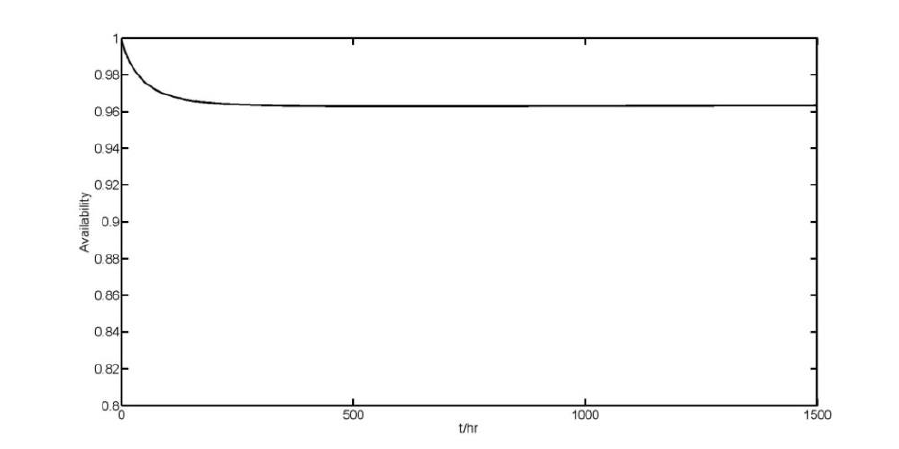
Figure 5. Availability of CNC Machine